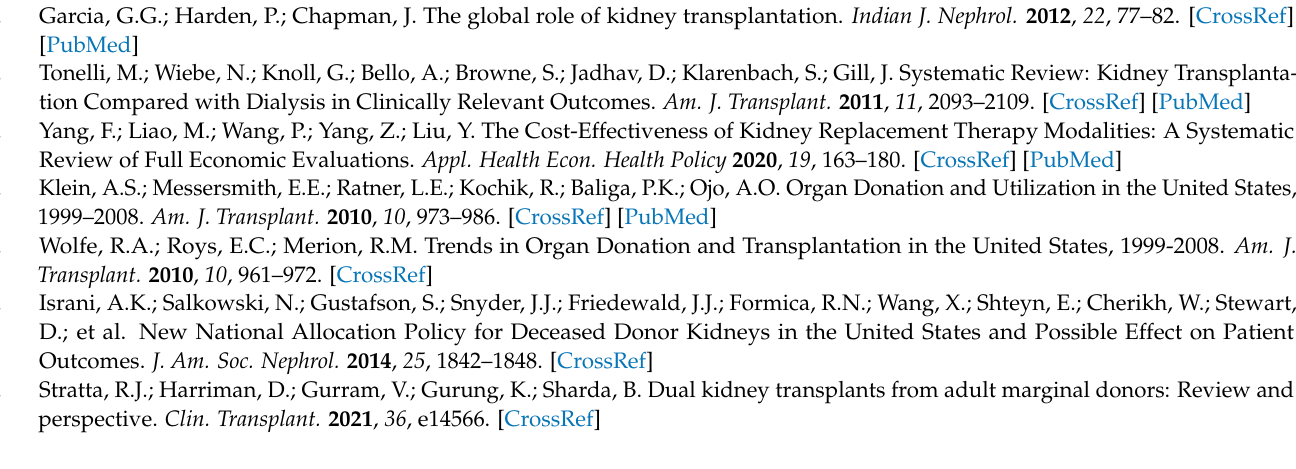
matrix heat map (k = 4) depicting consensus values on a white to blue color scale of each cluster; Figure S4. Consensus matrix heat map (k = 5) depicting con-sensus values on a white to blue color scale of each cluster; Figure S5. Consensus matrix heat map (k = 6) depicting consensus values on a white to blue color scale of each cluster; Figure S6. Consensus matrix heat map (k = 7) depicting consensus values on a white to blue color scale of each cluster; Figure S7. Consensus matrix heat map (k = 8) depicting consensus values on a white to blue color scale of each cluster; Figure S8. Consensus matrix heat map (k = 9) depicting con-sensus values on a white to blue color scale of each cluster; Figure S9. Consensus matrix heat map (k = 10) depicting consensus values on a white to blue color scale of each cluster. References [52–67] are cited in the supplementary